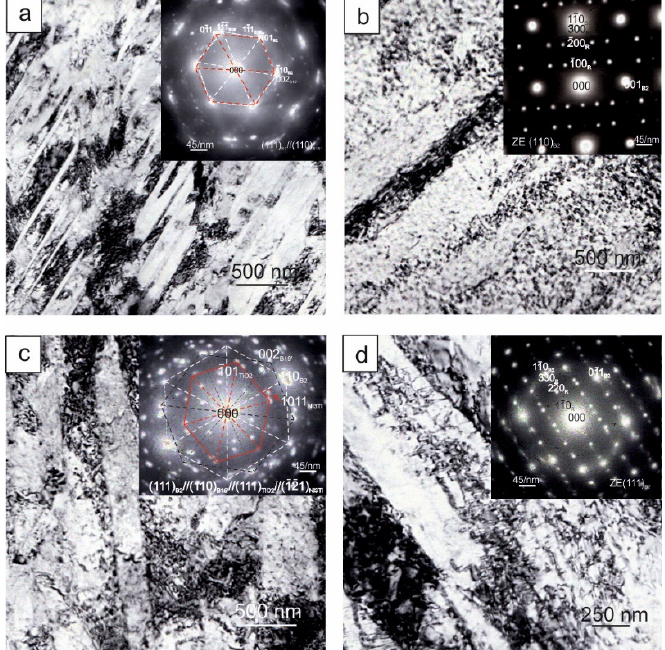
Figure 1. TEM images of microstructure of residual strain in the [011]-oriented Ti-50.1Ni single crystals after marforming at room temperature: ( a , b ) after annealing at 713 K for 0.5 h in helium gas; ( c , d ) after annealing at 713 K for 0.5 h in dry air.